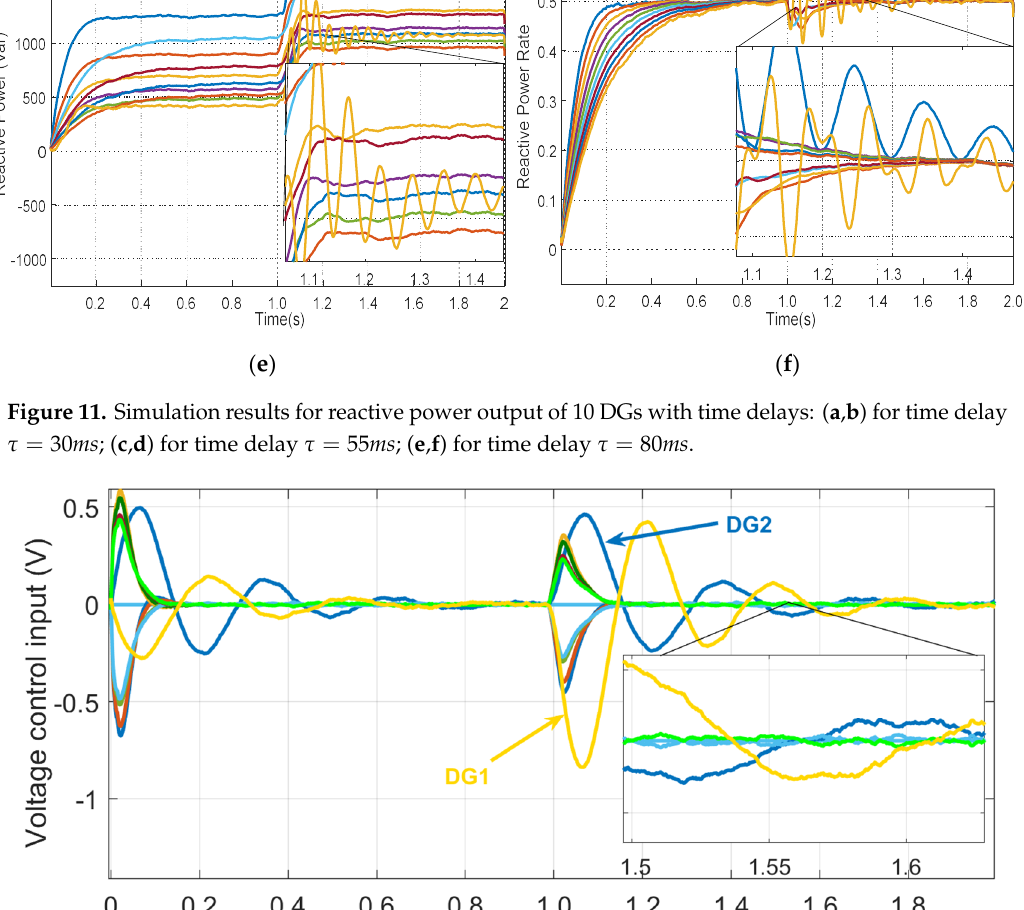
Figure 13. Control input with ETCP with time delay